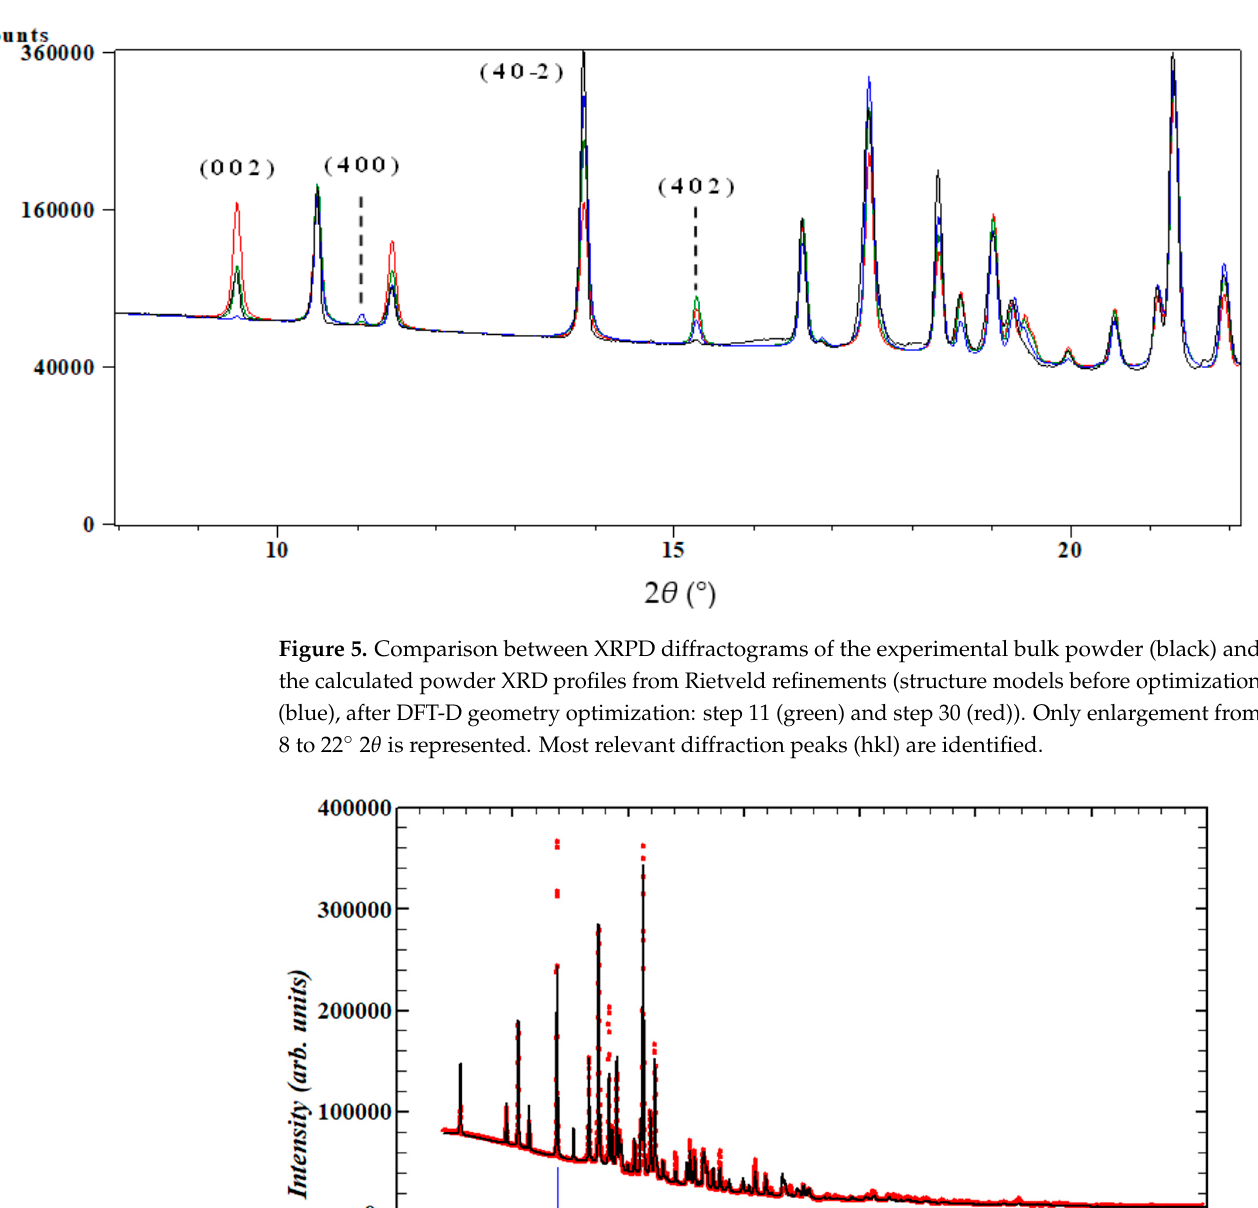
Figure 4. DFT optimization energy profile. Relevant optimization steps are colored: blue for the initial optimization step, black for 9, 10, 11 and 20 optimization steps, respectively and red for the final optimization step.